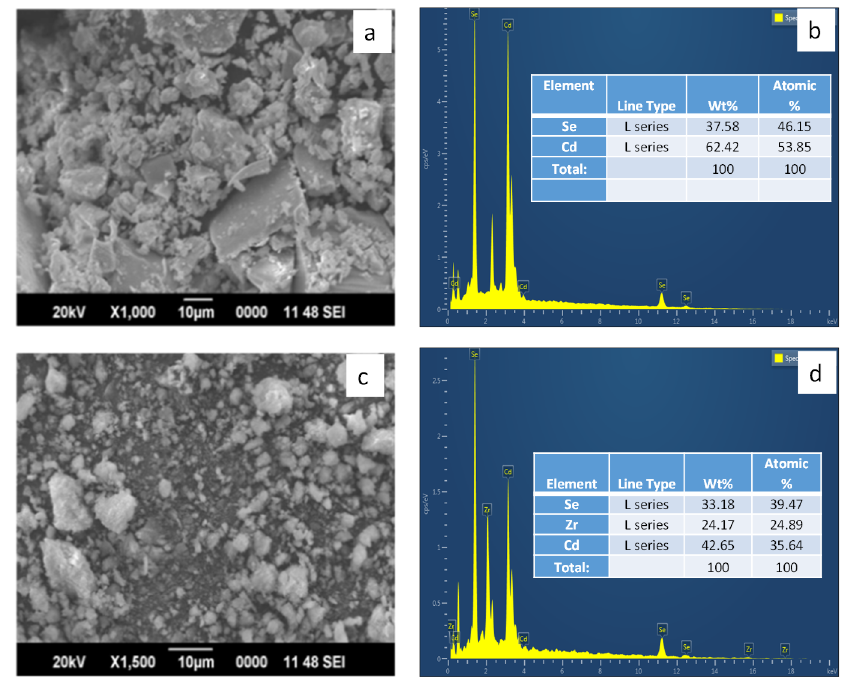
Fig. 4. SEM-EDAX images of CdSe (a, b) and Zr-CdSe (c, d) nanoparticles